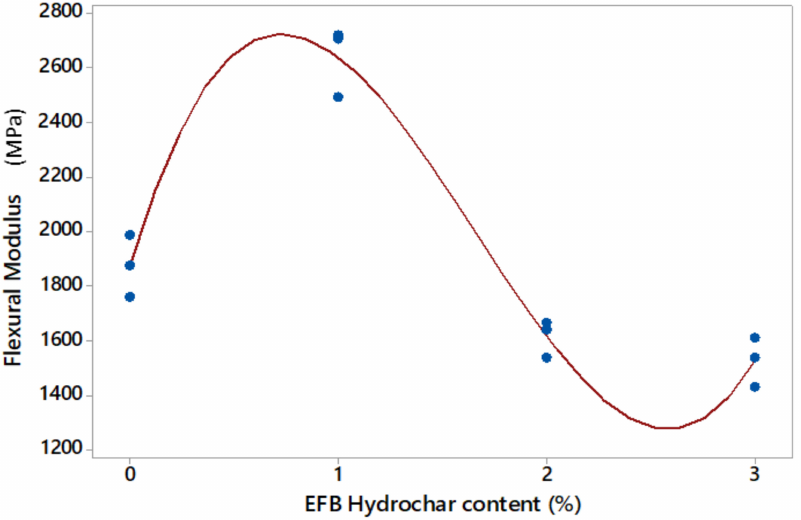
Figure 11. The cubic model of the relationship between the flexural modulus of the hydrochar content